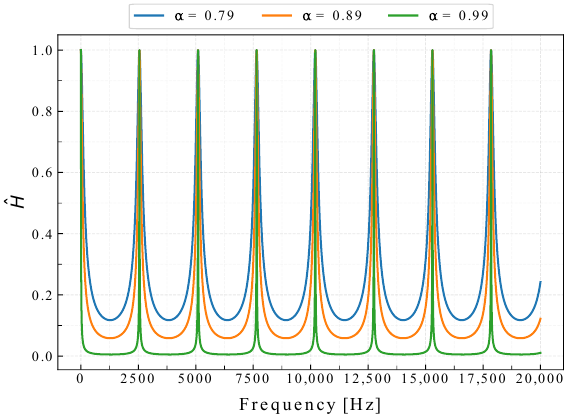
Figure 4. Normalized filters with different α values with f f = 2550